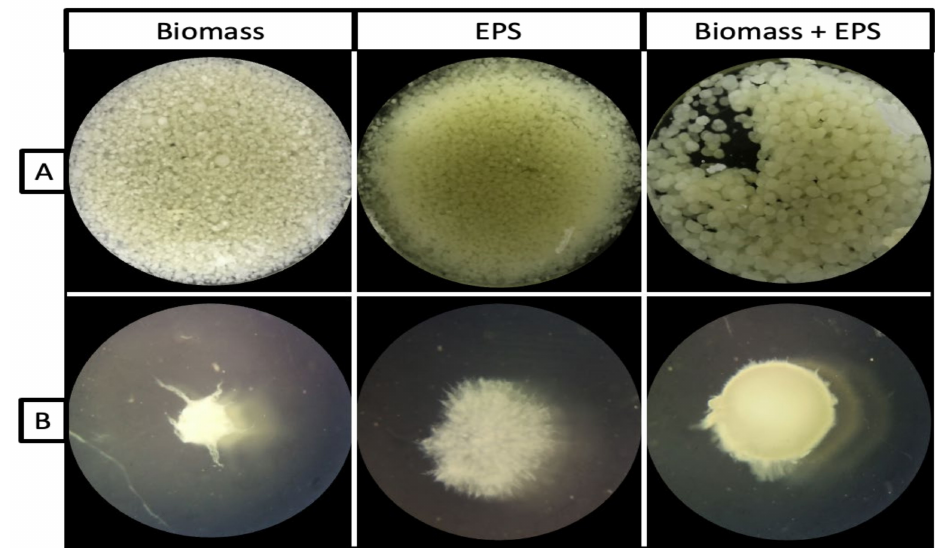
Figure 5. Macroscopic ( A ) and microscopic ( B ) morphological analysis of mycelium pellets in optimised media conditions for each